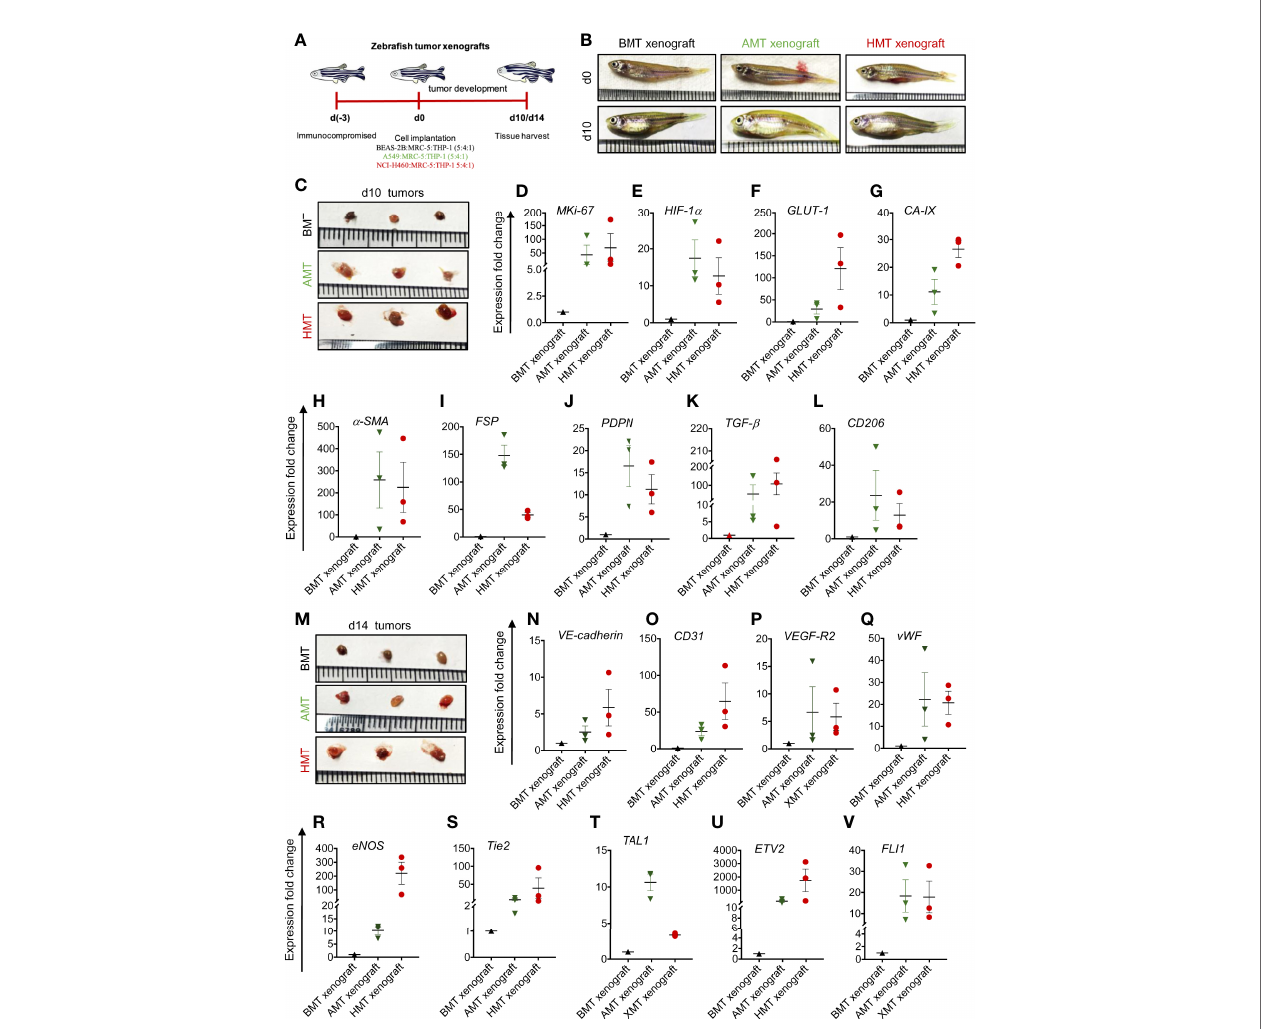
FIGURE 6 | Validation of 3D tumor spheroid data in zebra fi sh xenograft model. (A) Schematic diagram representing experimental design indicating days on which zebra fi sh was immunocompromised [d(-3)], mixed cell population was injected into the peritoneal cavity [d(0)], and BMT, AMT, and HMT xenografts were collected on d10 and d14. (B) Representative photographs of zebra fi sh on d0, and d10 of tumor development. (C) Representative photographs of zebra fi sh BMT, AMT, and HMT tumor xenografts (n=3) on day 10. (D-L) RT-qPCR analysis of different gene expression in BMT xenograft (black, n=3), AMT xenograft (green, n=3), and HMT xenograft (red, n=3) on day 10. (D) MKi-67 proliferation marker; (E – G) hypoxia related markers- HIF-1 a (E) , GLUT-1 (F) , and CA-IX (G) ; (H – K) cancer associated fi broblast markers- a -SMA (H) , FSP (I) , PDPN (J ) and TGF- b (K) ; (L) tumor associated macrophage marker CD206 ; (M) Representative photographs of zebra fi sh BMT, AMT, and HMT xenografts (n=3) on day 14. (N – V) RT-qPCR analysis of different gene expression in these xenografts on day 14. (N – R) endothelial cell markers- VE-cadherin (N) , CD31 (O) , VEGF-R2 (P) , vWF (Q) , eNOS (R) ; (S – V) angiogenic regulators Tie2 (S) , TAL1 (T) , ETV2 (U) , FLI1 (V) . GAPDH was used